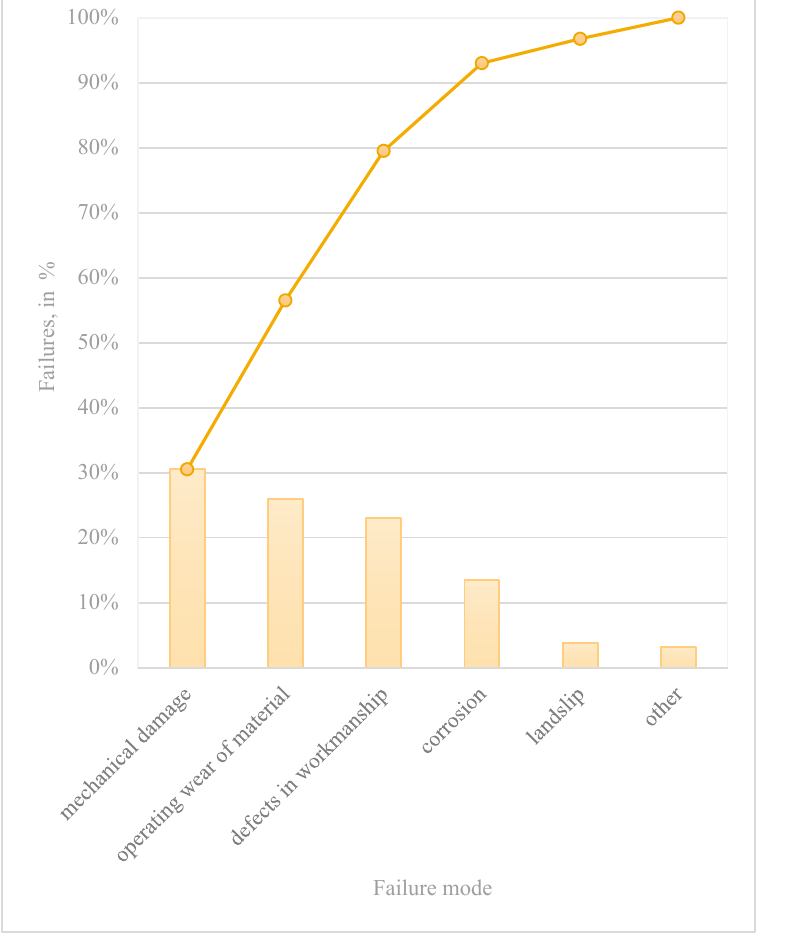
Figure 6. A Pareto-Lorenzo diagram depicting the reasons of a gas-supply network failure.